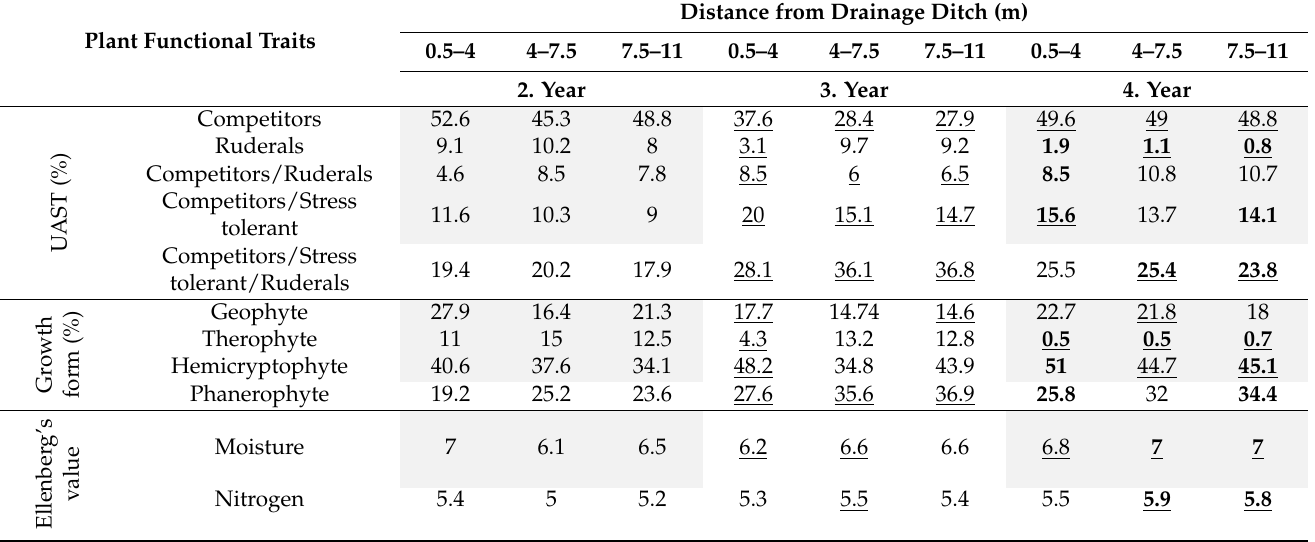
Table 2. Relative cover (proportion of total cover) of plants by strategy (UAST) and growth form and community weighted mean values for Ellenberg’s indicator values in plots depending on the distance from the drainage ditch during the observation period. Underlined text indicates significant differences in 3rd and 4th year of study with the previous season and bold text indicates significant differences between 2nd and 4th Year (Student’s t-test ( p <